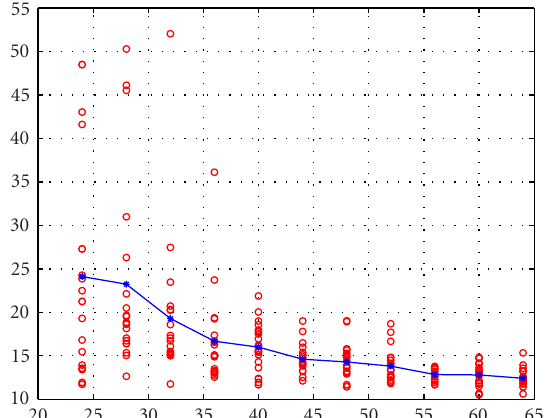
Figure 9: Average error versus the number of sensors in the field. The points marked with a circle are the error average over the track- ing steps. The points marked with “ ∗ ” and linked using a blue line is the average over 20